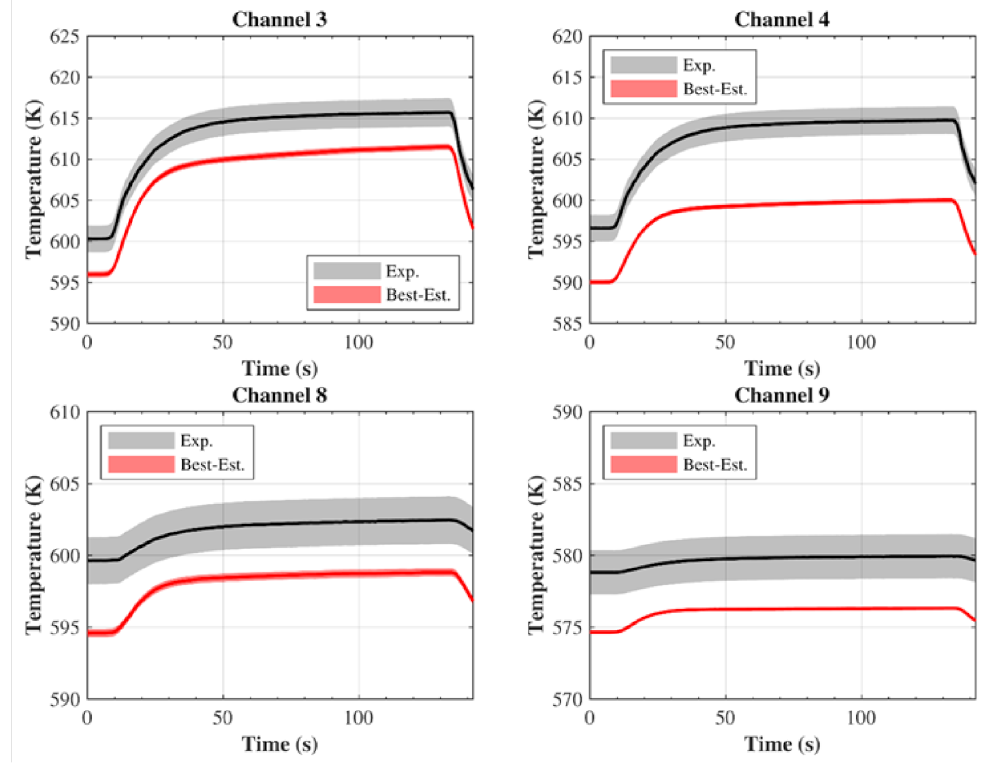
Figure 7. Outlet coolant temperature—300 kW/m 2 , 40% valve opening